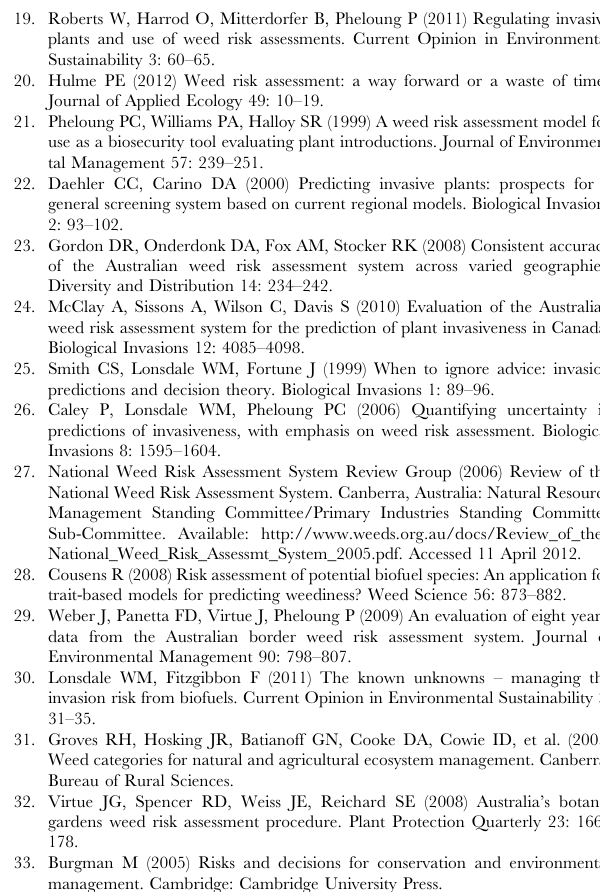
Table S1 Definition of each descriptive status category of records extracted from the original, pre-existing database to build the dataset for the SOM analysis.